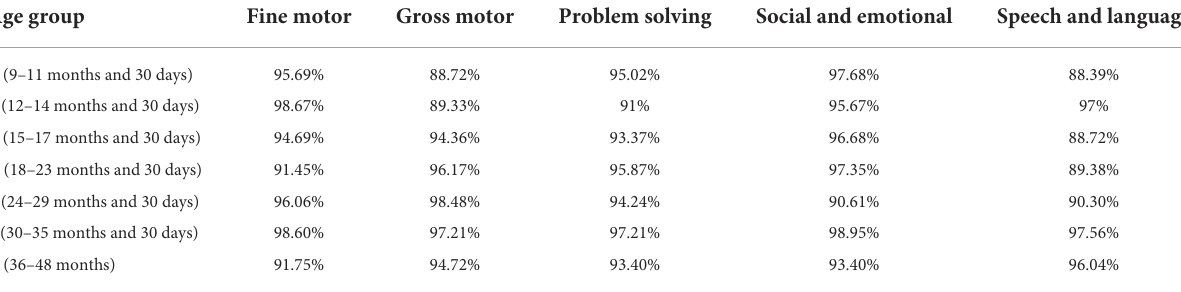
TABLE 5 Average pairwise percent agreement between the items within each domain for age groups in the Dubai Tool for Developmental screening (DTDS). Age group Fine motor Gross motor Problem solving Social and emotional Speech and